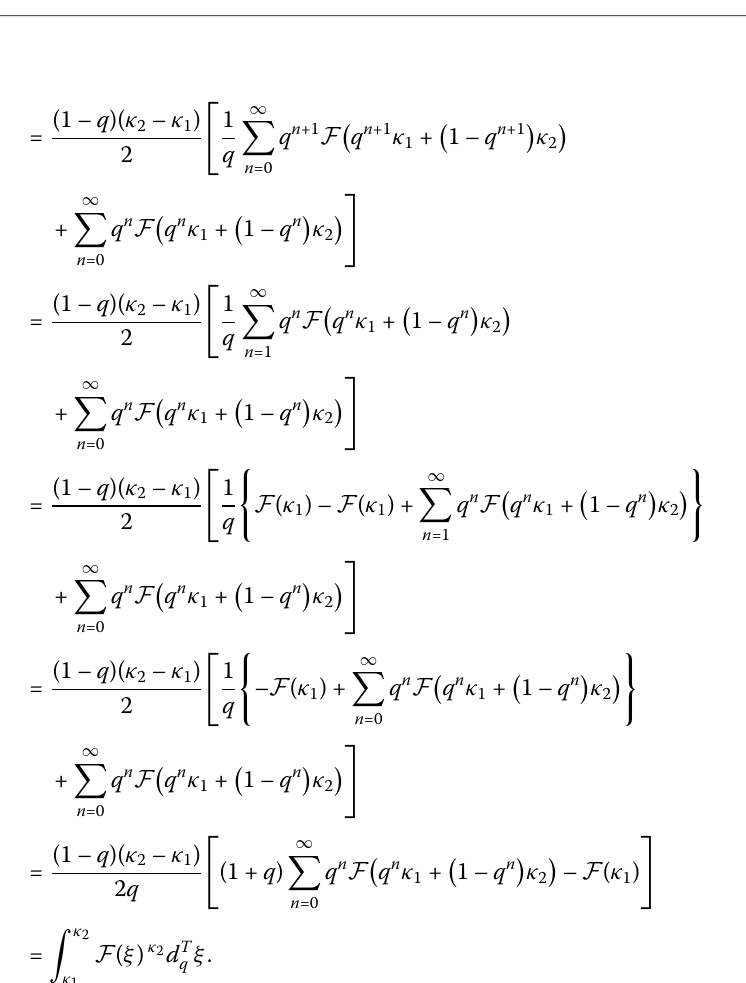
Figure 1 Areas of